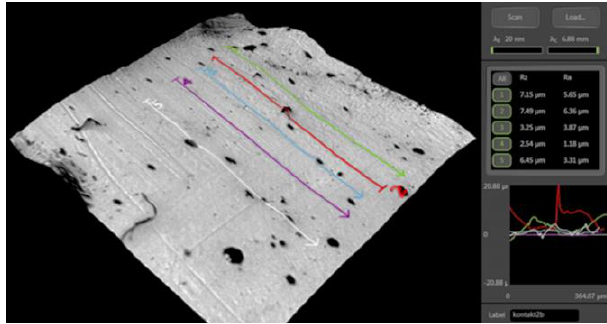
Fig. 11. Sample number 2, measurement 2 – 3D view of the test surface